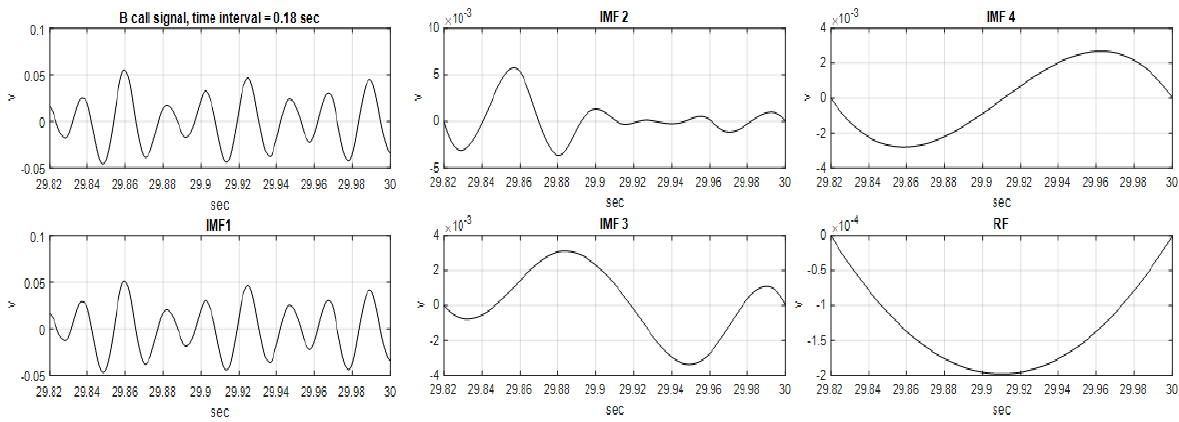
Figure 3. Four IMFs and one RF of one of the 59 BWBCV analysis samples, with a time interval of 29.82 to 30.00 s.